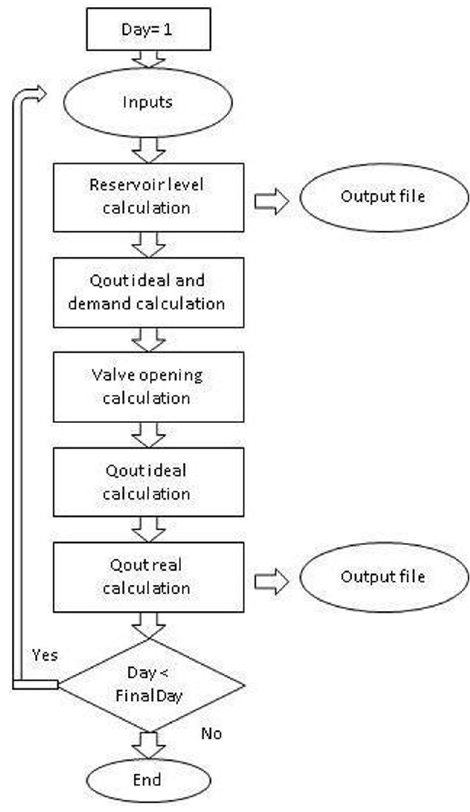
Fig. 2. Flow diagram of management